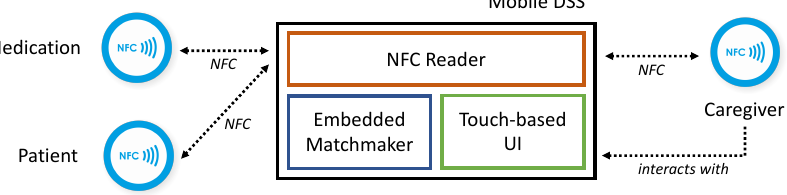
Figure 1. Clinical decision support system